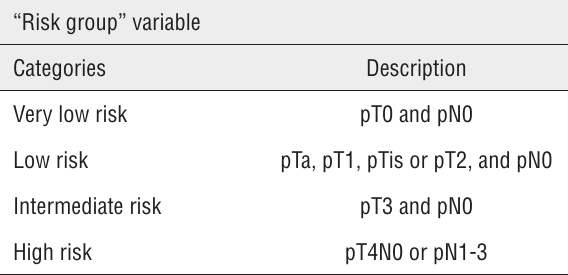
Pathological organ confinement Lymph node involvement